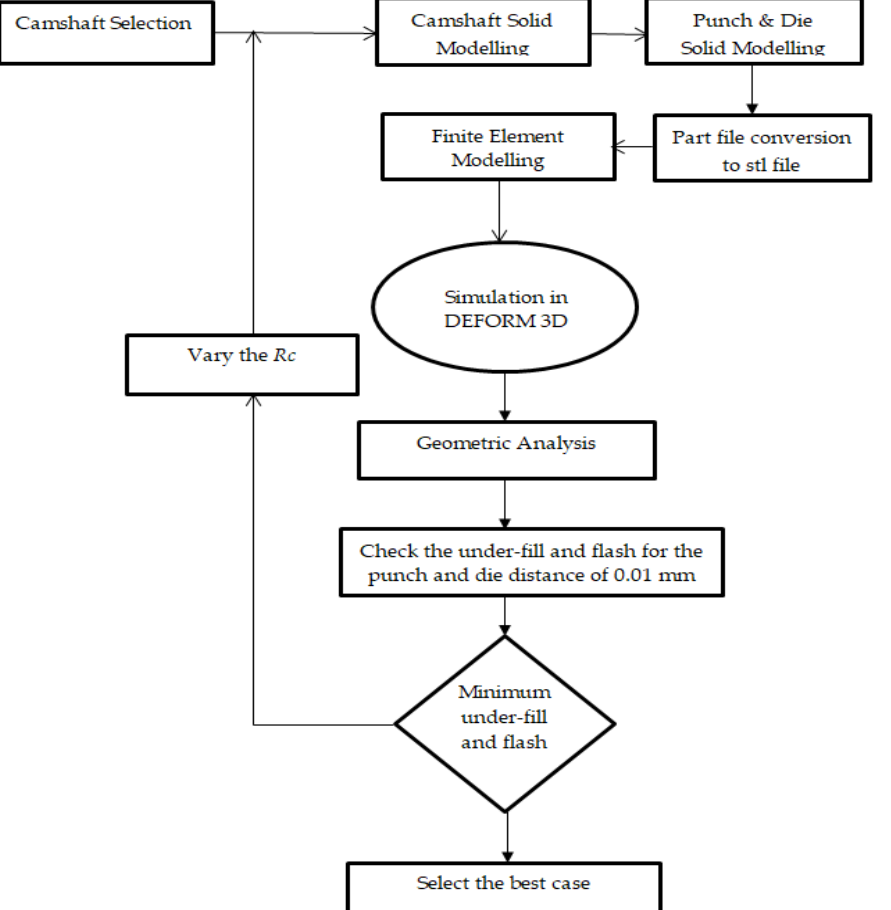
Figure 2. Flow chart emulating the basic workflow.